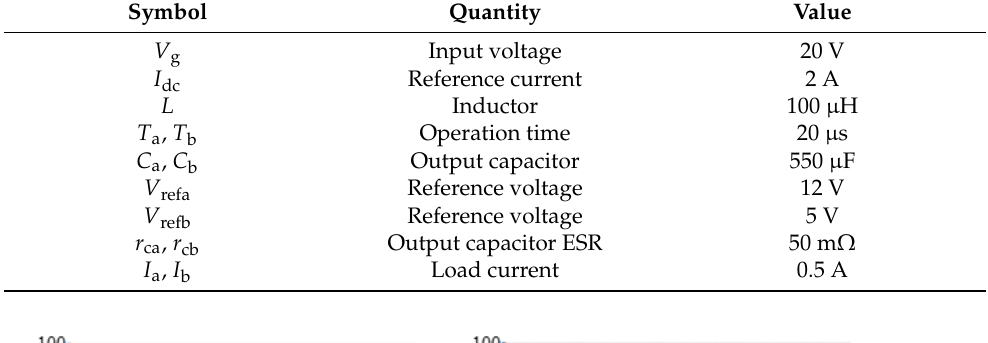
Table 1. Parameters of voltage ripple-controlled PCCM SIDO buck converter.